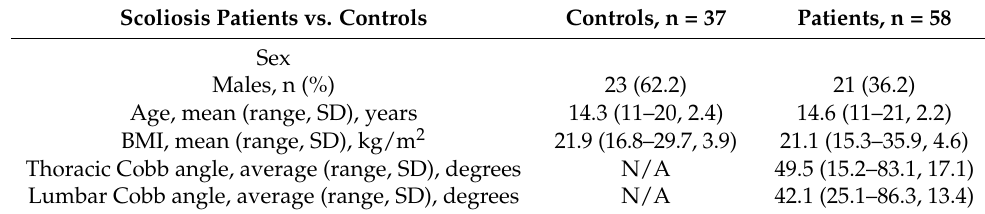
Table 4. Demographics, Scoliosis patients vs. control cohort. Scoliosis Patients vs. Controls